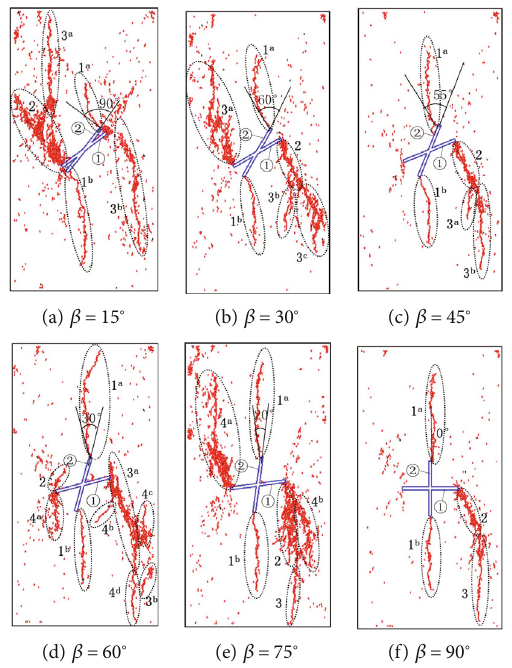
Figure 14: Failure modes of numerical models with di ff erent values of β ( α = 45 ° ). (Red represents tensile microcracks. Black represents shear microcracks. Numbers indicate the order of macrocrack generation. The angle values indicate the crack initiation angle).